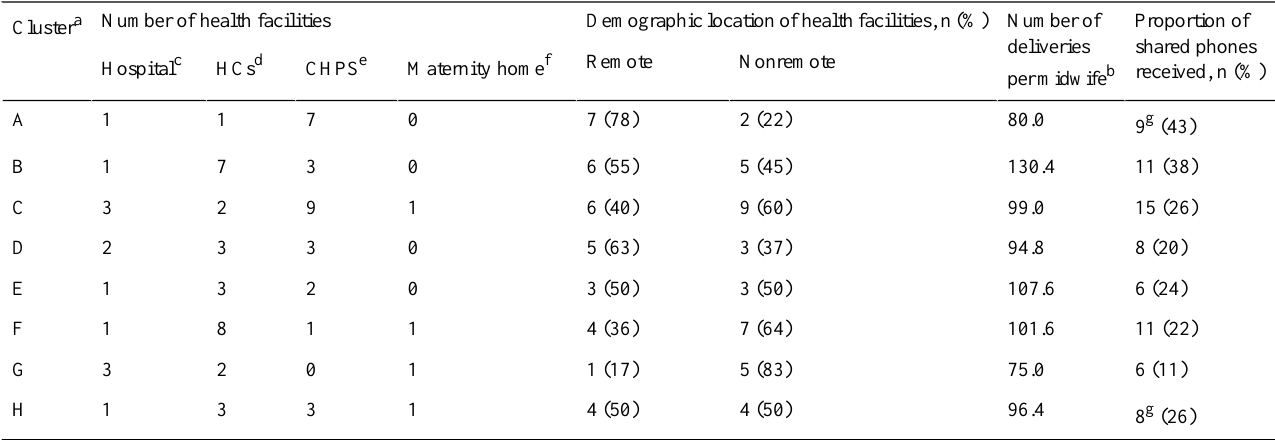
Table 1. Background characteristics of